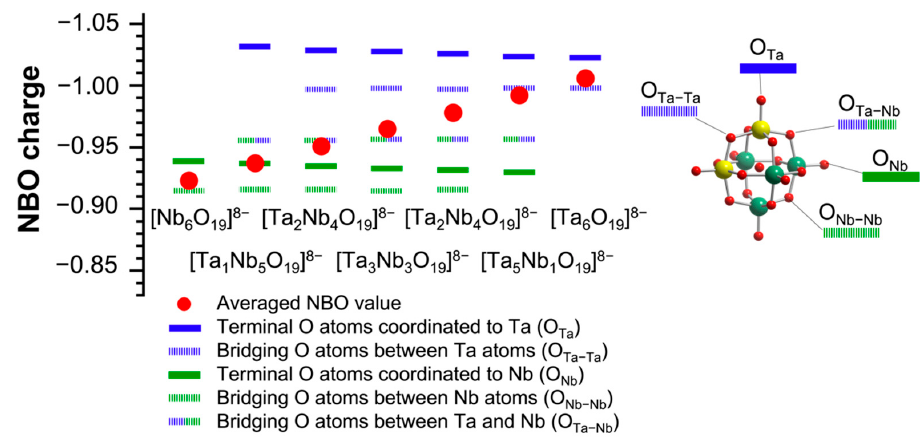
Figure 6. NBO charge of surface O sites of [Ta x Nb 6 − x O 19 ] 8 − . Color codes: yellow atom, Ta; green atom, Nb; blue line, Ta-coordinated O atoms; green line, Nb-coordinated O atoms; red, total O atoms. Red circle represents the averaged value. Terminal and bridging O atoms represent solid and dashed lines, respectively.